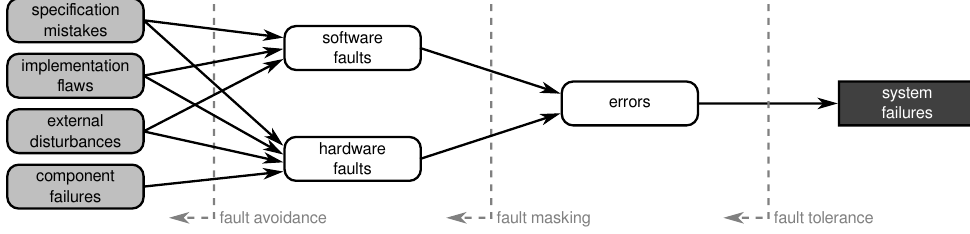
Figure 4. The cause-and-effect relationship of faults (after Figure 2 in [19]).